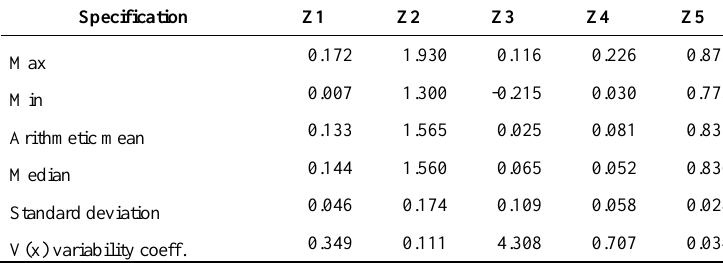
Table 4. The basic characteristic for selected diagnostic variables (Option 2)